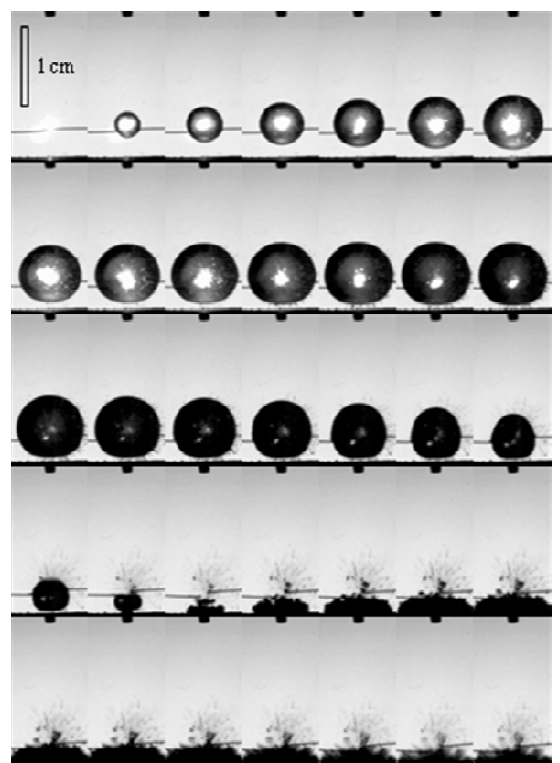
Fig. 7. Collapse pattern 3 – high-speed camera record. Time distance between the frames is 62.5 µ s.